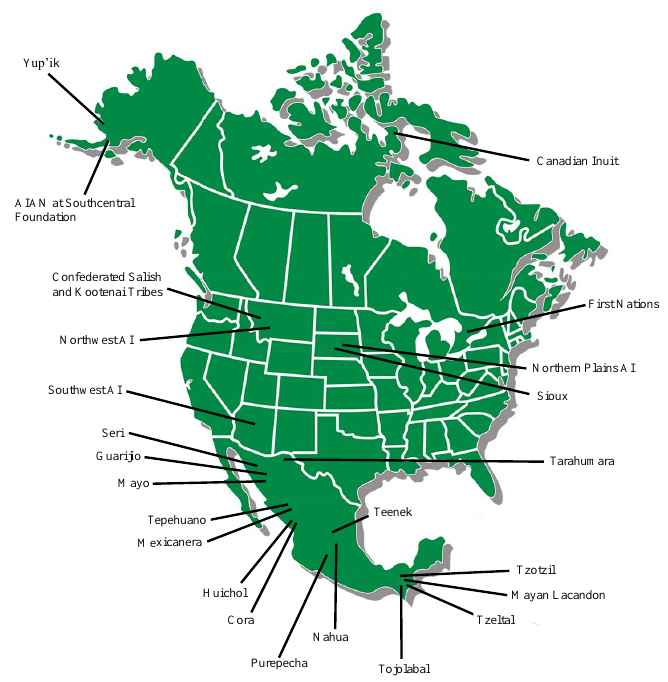
Figure 2. Map of North America with general locations of Indigenous populations included in this review. Table 1. Studies of P450 genetic polymorphisms in Indigenous North American populations.